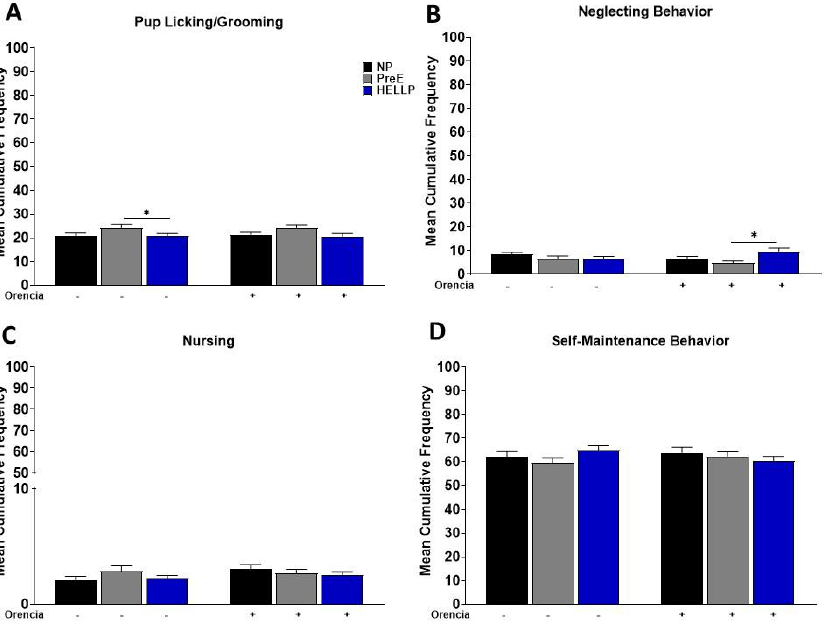
Figure 2. Cumulative frequency of maternal pup interaction from post-partum days 3 to 7 was evaluated. Pup/licking-grooming ( A ), neglecting behavior ( B ), nursing ( C ) and self-maintenance behavior ( D ) were evaluated during both the light and dark period, and data were combined. Data were analyzed by two-way ANOVA followed by Tukey’s post hoc test and presented as mean ± SEM (n = 11–13 dams/group). * denotes p < 0.05 in comparison to the indicated group. Abbreviations: NP (normal pregnant); PreE (preeclampsia); HELLP (hemolysis elevated liver enzyme low platelet). Depressive-like behavior was assessed by measuring immobility in the forced swim test. Immobility time in the forced swim test was evaluated to assess depression. There was a significant group effect [F 2,56 = 13.56, p < 0.0001] and group x treatment effect [F 2,56 = 4.99, p = 0.01] on immobility time for the forced swim test. Both PreE ( p = 0.002) and HELLP ( p = 0.006; Figure 3A) dams had increased immobility time relative to NP rats. The infusion of Orencia into HELLP rats significantly reduced the amount of time rats spent in the immobile state compared to uninfused HELLP dams ( p = 0.04), whereas PreE + Orencia dams spent significantly more time immobile relative to NP + Orencia ( p = 0.005), HELLP + Orencia ( p < 0.0001) and PreE rats ( p = 0.04).